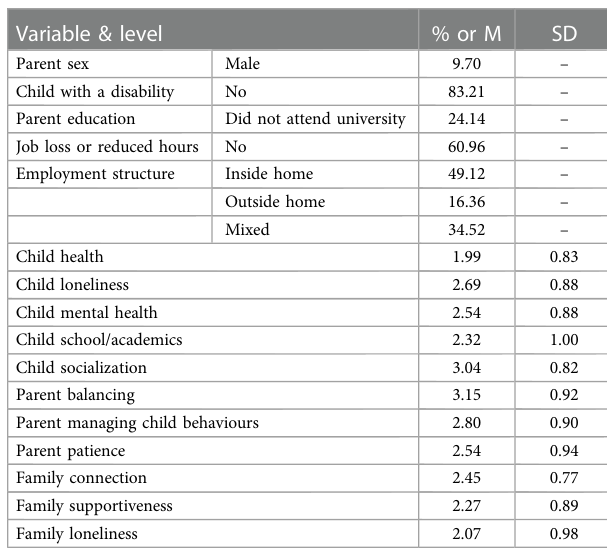
TABLE 1 Descriptive statistics for study